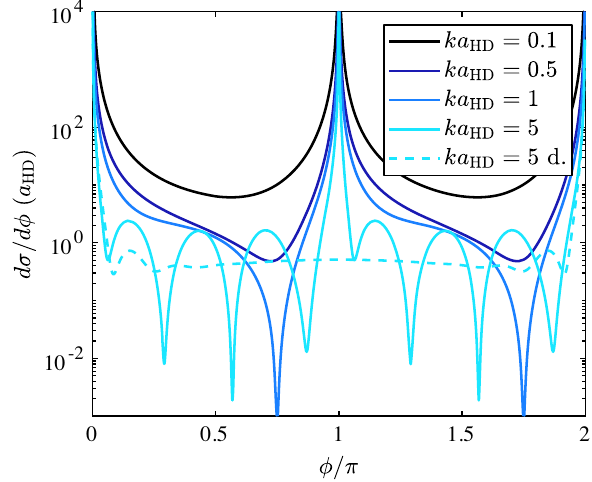
FIG. 3. Differential scattering cross section d σ =d ϕ in units of the hard-core radius a as a function of the scattering angle ϕ for HD a hard-disk interaction potential V between bosonic impurities ii immersed in a ν ¼ 0 . 5 FQH fluid. The different solid curves correspond to indistinguishable impurities with different values of the relative incident momentum ka . The larger ka , the HD HD more visible is the fringe pattern resulting from the interference of direct and exchange scattering channels. For comparison, the 5 : In dashed curve shows distinguishable impurities at ka HD ¼ this case, no interference fringe is visible.